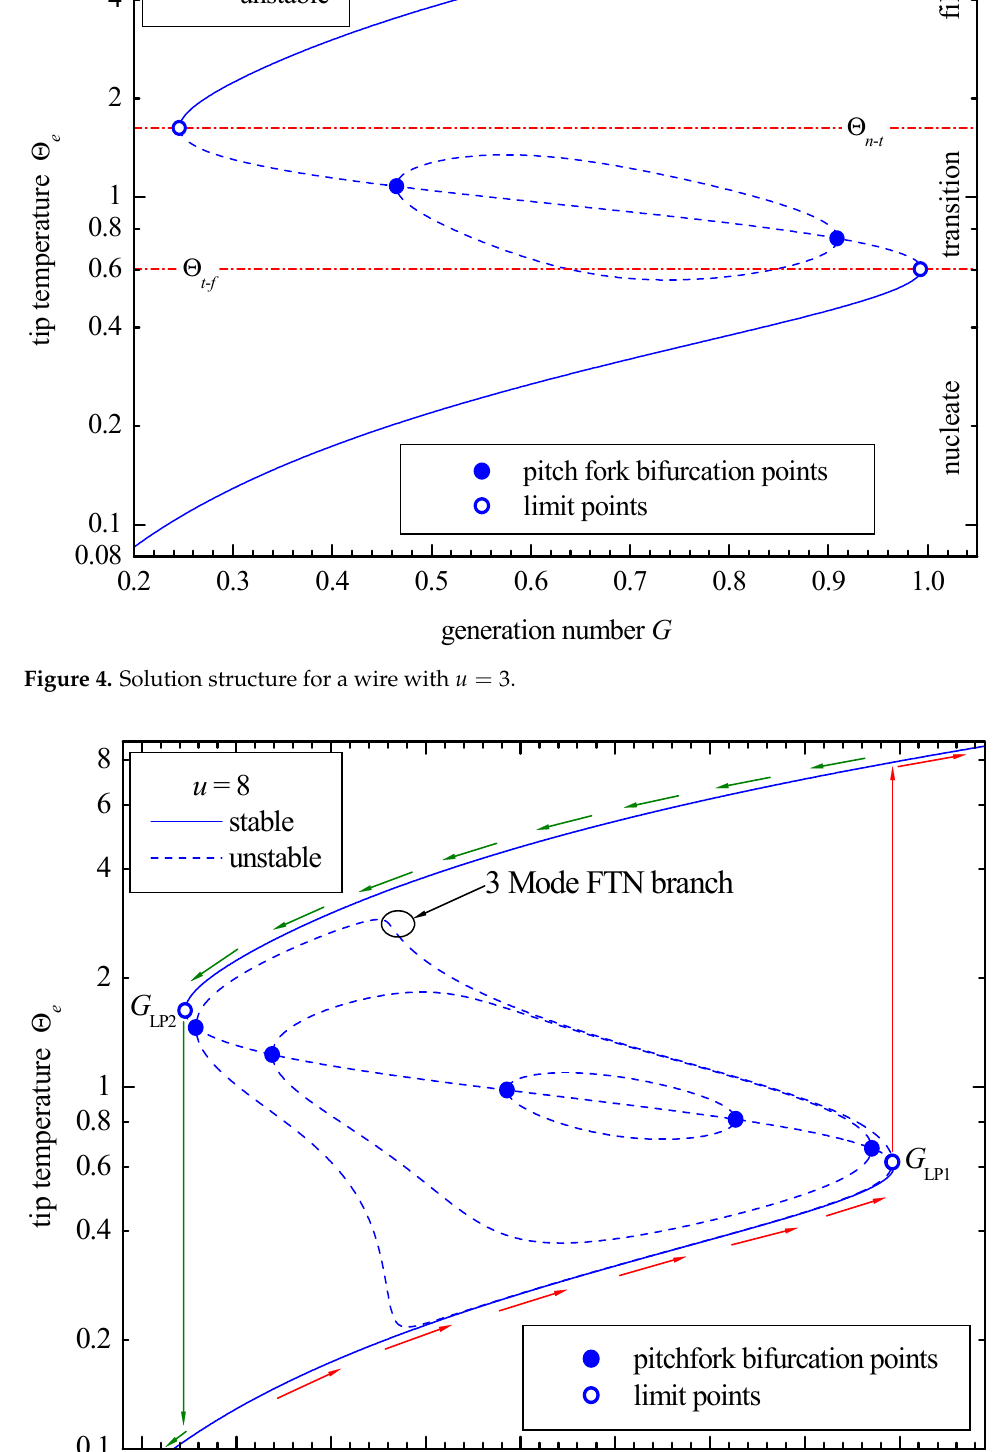
Figure 5. Solution structure for a wire with 𝑢 = 8 .